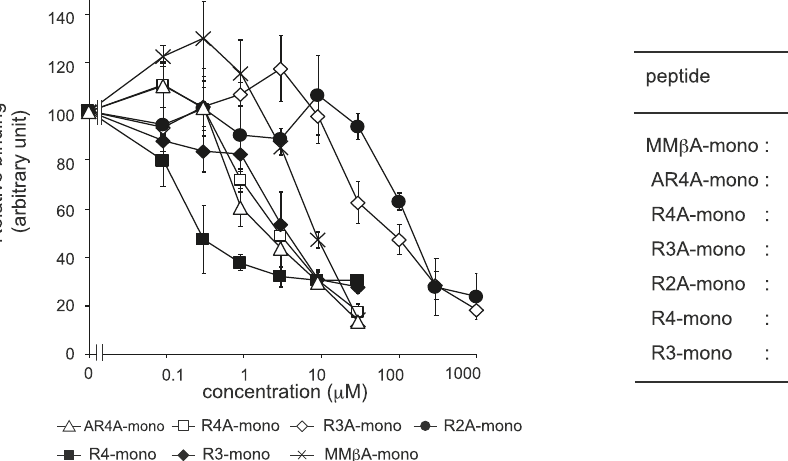
Figure 1. A series of shorter MMβA-mono-derived peptides inhibit binding between the Stx2a A-subunit and MMβA-mono. The inhibitory effects of a series of shorter MMβA-mono-derived peptides on binding between the Stx2a A-subunit and MMβA-mono were measured using the AlphaScreen assay. Relative binding is shown in the left panel, and peptide amino acid sequences and IC50 values are shown in the right panel. Data are presented as a percentage of the control value without peptides (mean ± standard error [SE], n =